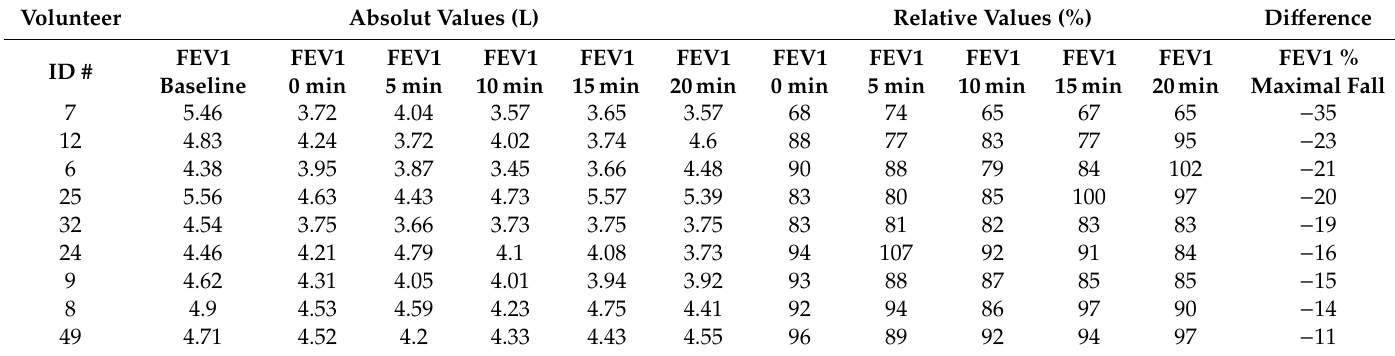
Note: The highlighted values indicate the moments when the drop in FEV1 was equal to or higher than